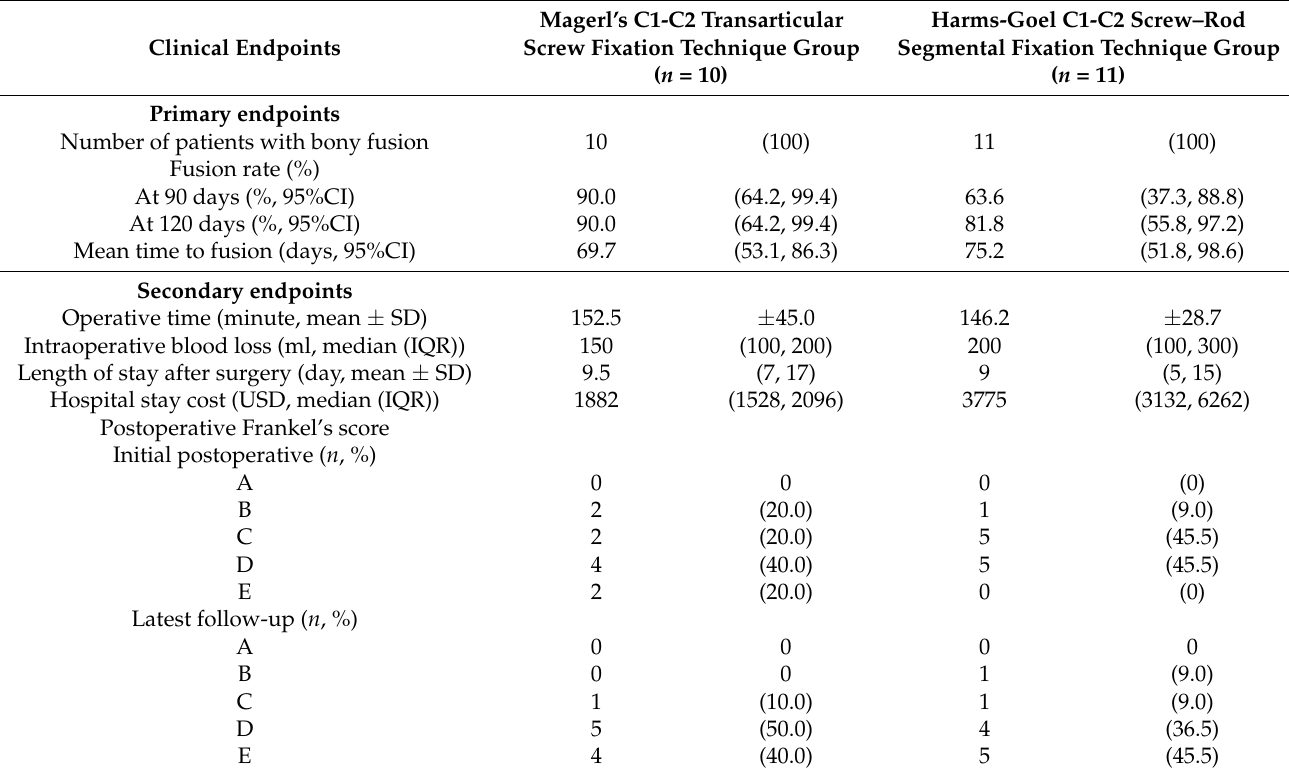
Figure 4. Kaplan-Meier curves for fusion probability in both study groups. The blue line depicted the fusion probability of patients in Magerl’s C1-C2 transarticular screw fixation technique group. The red line depicted the fusion probability of patients in the Harms-Goel C1-C2 screw-rod segmental fixation technique group. Table 2. Primary and secondary